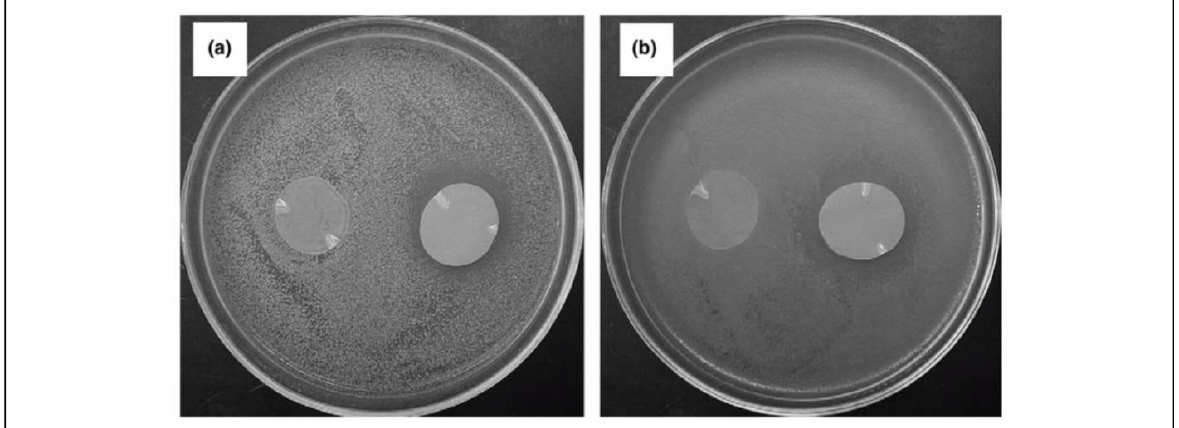
Figure 13: Alginate edible film’s inhibitory zone of incorporated with 3% v/v garlic oil (right strip) compared to control (left strips) against (a) Staphylococcus aureus and (b) B. cereus. Retrieved from Pranoto et al .,